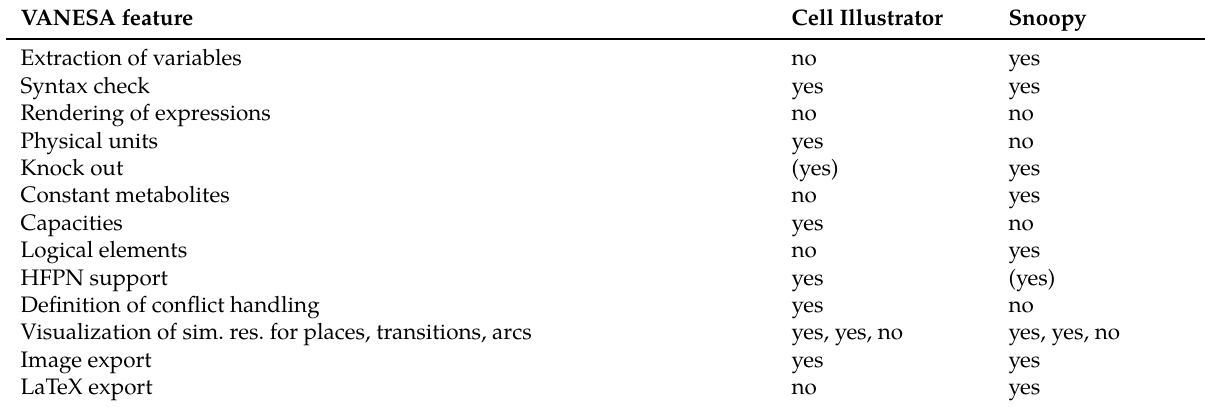
Table 1: Comparison of new features of VANESA with Cell Illustrator and Snoopy. VANESA